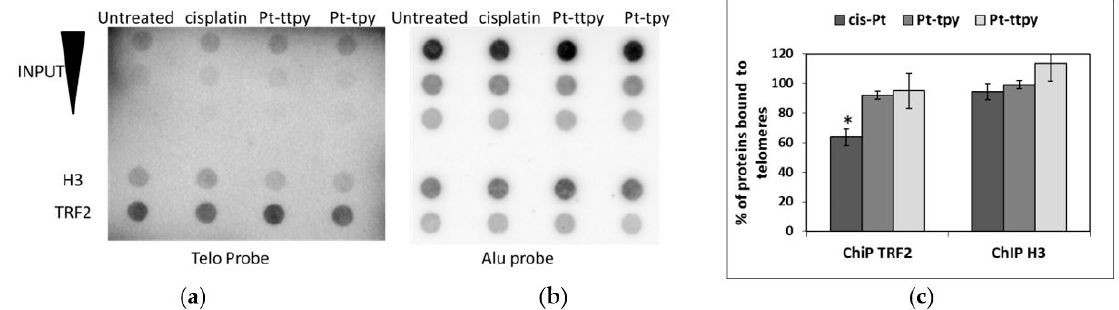
Figure 4. Quantification of TRF2 binding to telomeres by ChIP on A2780 cells treated with cisplatin, Pt-ttpy, or Pt-tpy for 8 h at 50 µM using anti-H3 and anti-TRF2 antibodies. The telomeric sequences immunoprecipitated by the anti-TRF2 or the anti-H3 antibodies were visualized after incubation of the dot blot membrane with a α 32 P radiolabelled 800 pb telomeric probe ( a ); signal normalization was performed after hybridization of the same membrane with α 32 P radiolabelled Alu sequences ( b ); two hundred nanograms of DNA were blotted for each ChIP sample. For the INPUT, 200, 100, and 50 µg of total DNA were blotted; ( c ) quantification of three ChIP experiments performed as in ( a ). Data were expressed as a percentage of the telomeric DNA signals in treated vs untreated cells. Quantitative values of the telomeric DNA signals are calculated as the ratio between the telomeric DNA signal precipitation and telomeric DNA signals in the INPUT for the same amount of blotted DNA. These values have been normalized to the amount of blotted DNA for each sample quantified by the non-specific Alu probe, following the formula: (telomere IP/telomere INPUT)/(Alu IP/Alu INPUT). (Means of at least three experiments) * Indicates a Mann and Withney test p -value p < 0.05 (GraphPad PRISM software, RITME, Paris,